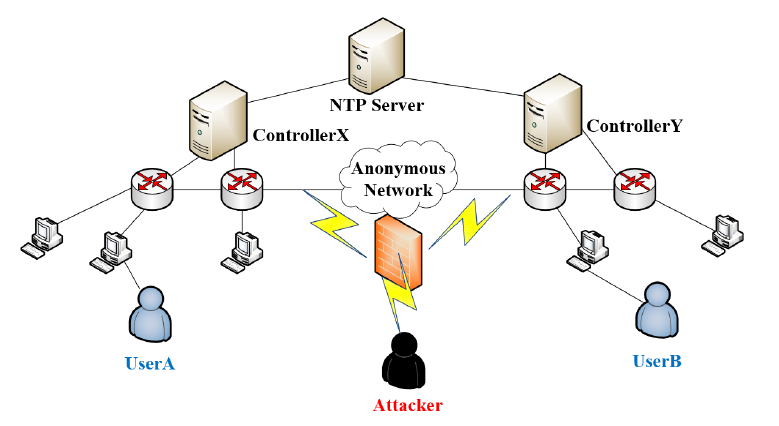
Figure 3. SDN-based Anonymous Communication Tracking (SACT) system model.